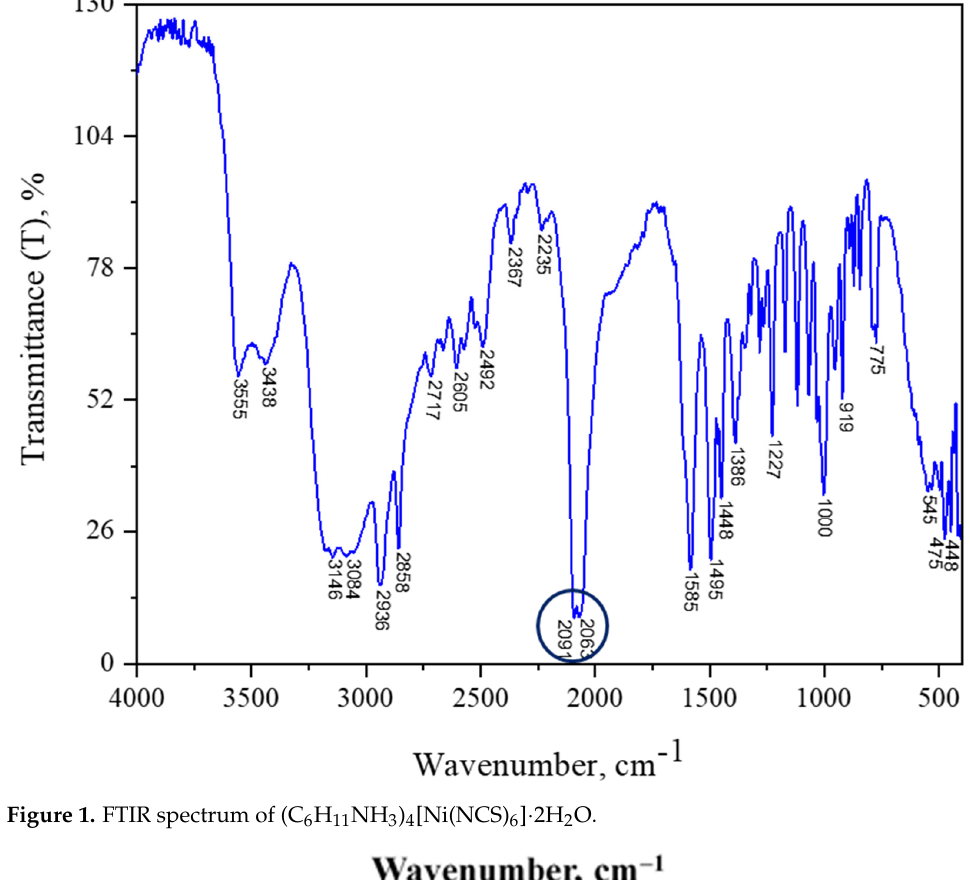
Figure 2 shows the UV-Vis-NIR absorbance spectrum of (C 6 H 11 NH 3 ) 4 [Ni(NCS) 6 ].2H 2 O, in methanol, at room temperature, as a function of energy